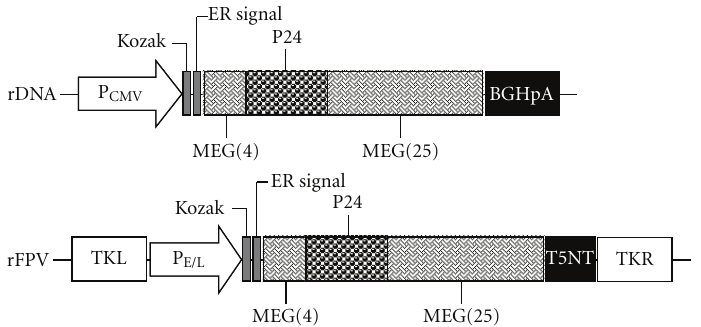
Figure 1: Schematic representation of the rDNA and rFPV vaccine constructs. The functional elements of the expression vector are the following. P CMV : human cytomegalovirus (CMV) immediate-early promoter/enhancer; Kozak: a Kozak translation-initiation sequence and an initiation codon (ATG) for proper initiation of translation; ER signal: endoplasmic reticulum signal peptide; MEG(4): multi-epitope gene (including 4 epitopes); P24: HIV-1 capsid protein; MEG(25): multi-epitope gene (including 25 epitopes); BGHpA: Bovine growth hormone (BGH) polyadenylation signal; TKL: the left recombinant fowlpox virus; P E / L : early and late promoter of fowlpox virus; T5NT: terminal signal of fowlpox virus; TKR: the right recombinant fowlpox virus.